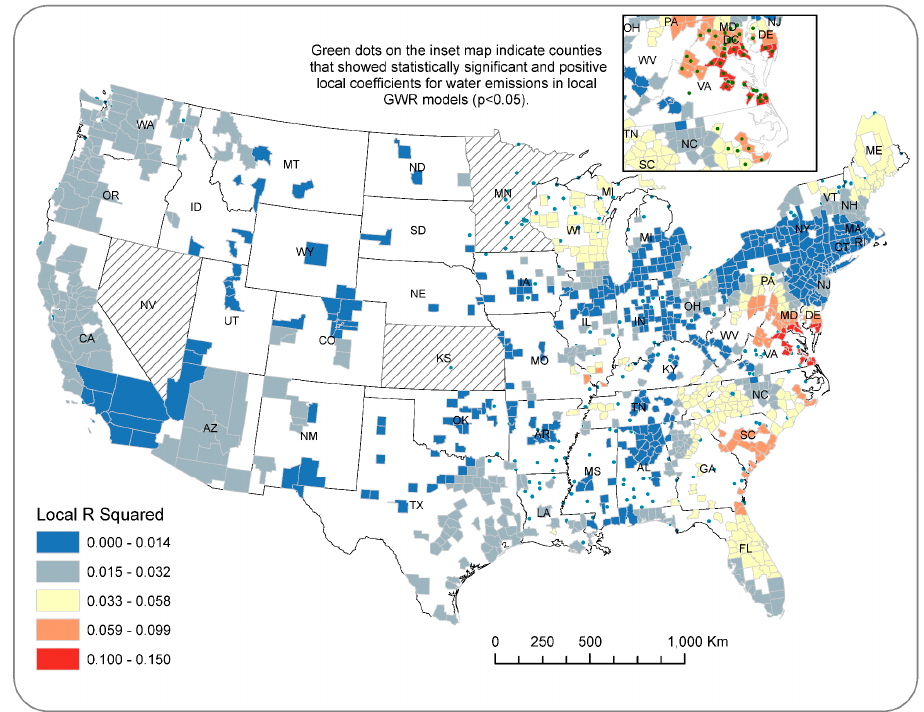
Figure 6. Results of local regression parameters from geographically weighted regression (GWR) models for All Emissions showing spatially varying explanatory power (i.e., local R squared values) for the county ‐ level data. Table 2. Results of OLS regression for county ‐ level data ( n = 987).